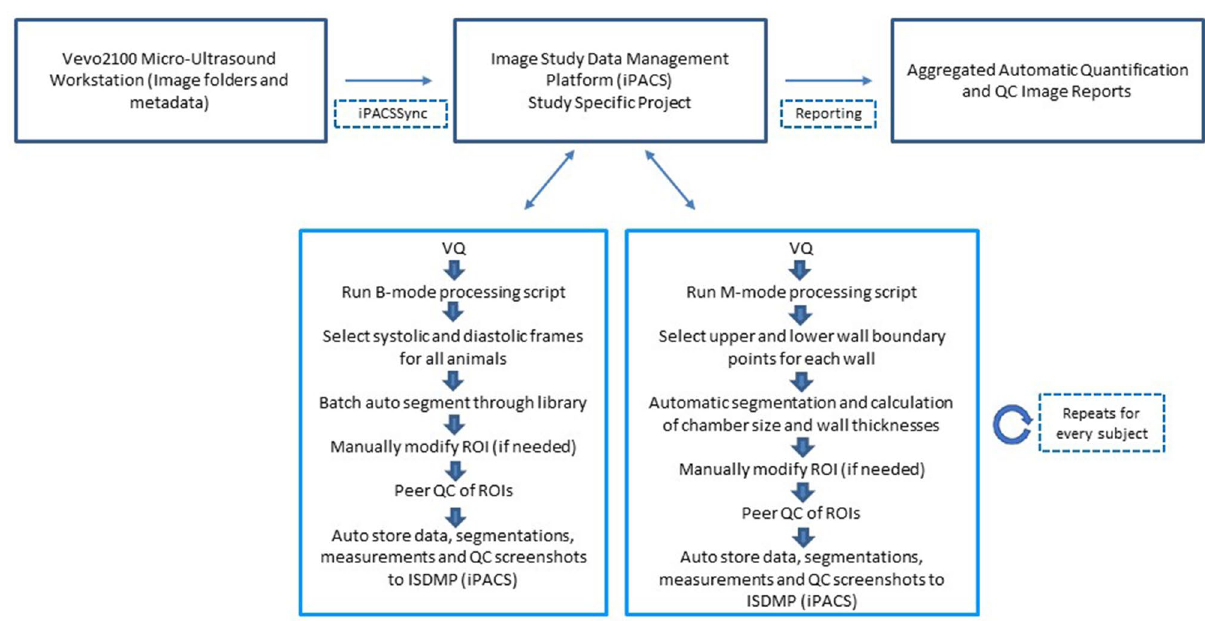
Figure 1. Semi-automated segmentation tool flowchart: pictorial representation of the semi-automated segmentation workflow for analyzing B-mode and M-mode